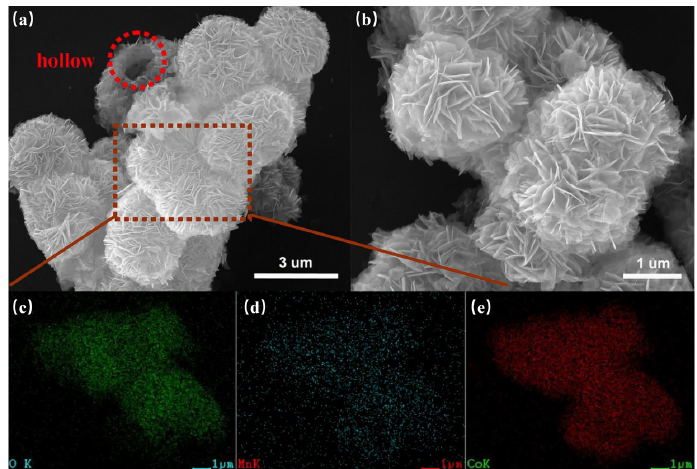
Figure 6. SEM images ( a , b ) of the calcined MnCo 2 O 4 products and the corresponding elements mapping ( c – e ) taken from the square area marked in Figure 6a. Reproduced with permission from Hongwei Che, Template-free synthesis of novel flower-like MnCo 2 O 4 hollow microspheres for application in supercapacitors; published by Elsevier, 2016 [87] .